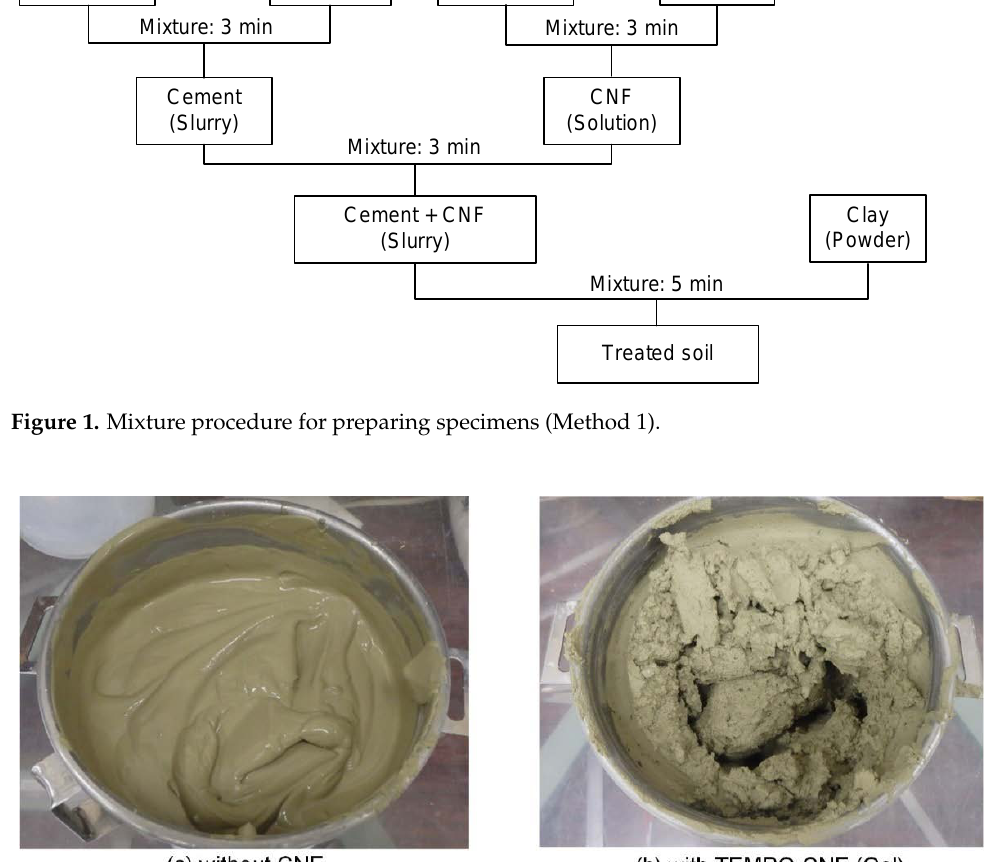
Figure 1. Mixture procedure for preparing specimens (Method 1).